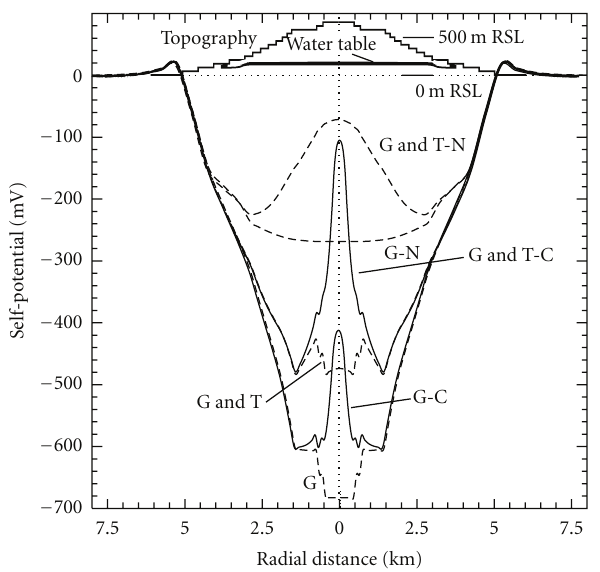
Figure 7: Self-potential distributions computed from numerical simulation results of thermohydraulic processes within a volcanic body, after [17]. Cases “G-” and “G and T-” correspond to the conditions of “steady-state of topography-driven groundwater flow” and “100 years after continuous heating of central conduit below sea level”, respectively. For cases “-C”, a shallow conductor above the water table is assumed. For cases “-N”, the drag current in the unsaturated zone is neglected. The “W”-shaped SP profile observed at Izu-Oshima volcano is reproduced by case “G and T- C”. The sketch in the upper part of the figure illustrates the earth surface topography and the water table